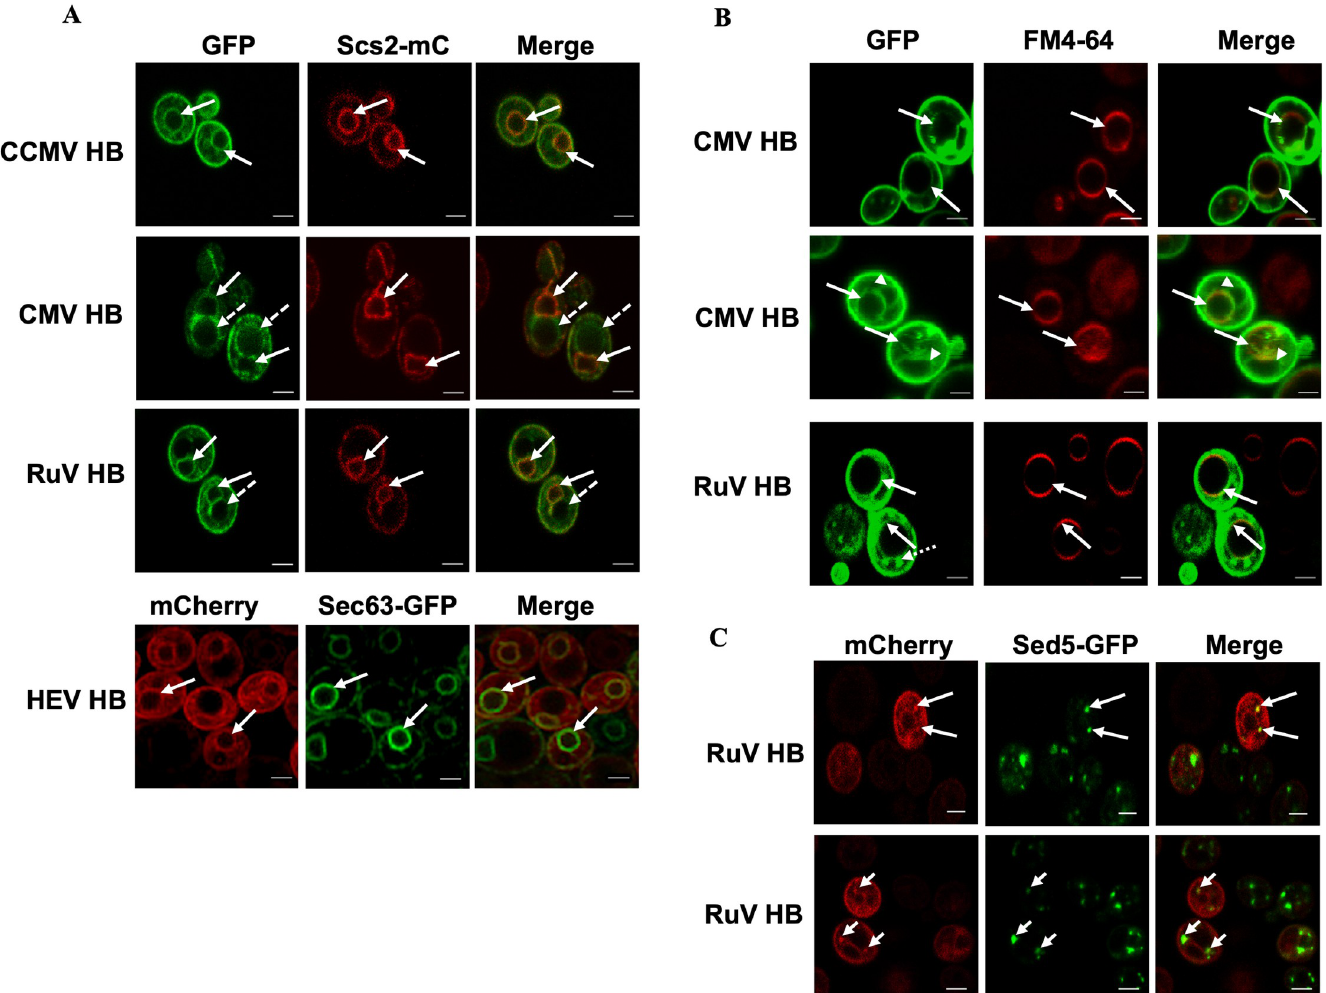
Fig 4. Helix B-mediated organelle targeting is conserved across members of the Alsuviricetes class. (A) Colocalization of GFP-tagged HB of CCMV, CMV, or RuV with an ER marker Scs2-mC, and colocalization of the mC-tagged HEV HB and Sec63-GFP at the nER membrane. Solid arrows point to the nER membrane and dotted arrows point to the putative vacuole membrane. (B) Colocalization observed for CMV HB and RuV HB with vacuole membranes stained by a lipophilic dye, FM4-64 [34]. The solid arrows point to vacuolar membranes, the arrowheads point to the putative nER membrane, and the dotted arrow in the RuV-HB panel shows punctate structures. (C) Colocalization of RuV HB-mC with GFP-tagged Sed5, a marker for vesicles that traffic from the ER to the Golgi. Images were obtained using a confocal microscope. Scale bars: 2 μ m.